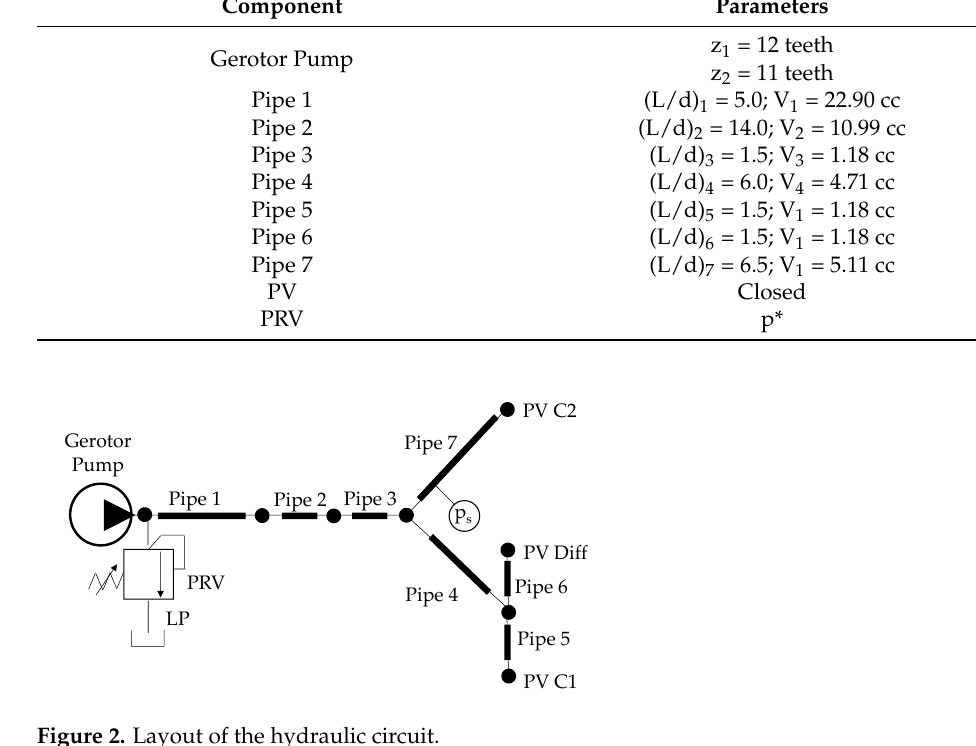
Figure 2. Layout of the hydraulic circuit. Table 1. Hydraulic circuit parameters.